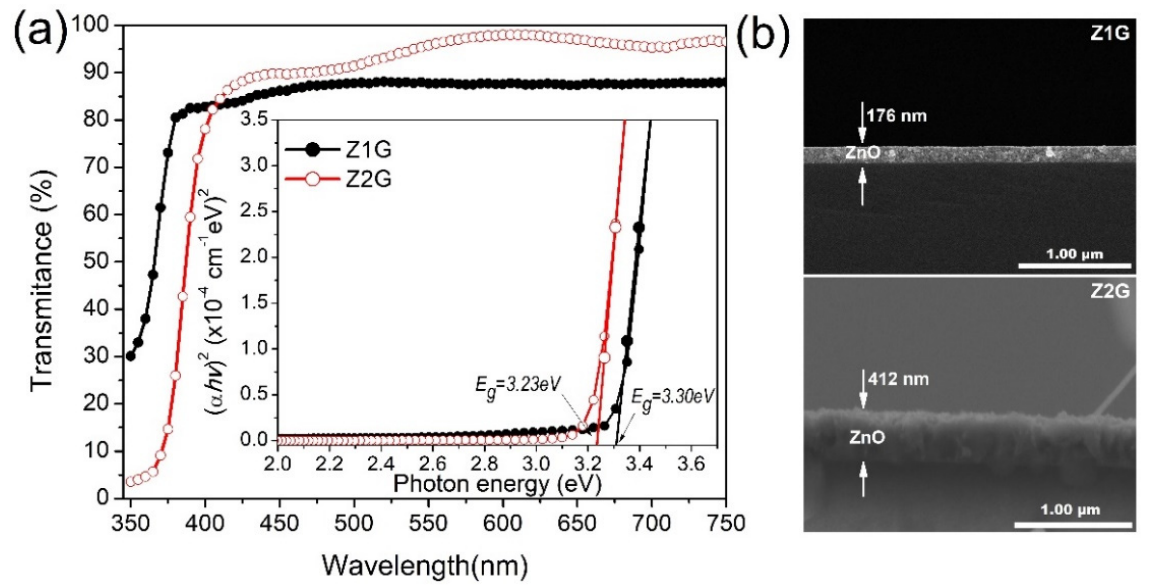
Figure 1. ( a ) Optical transmittance and band gap properties; and ( b ) cross-sectional SEM images of ZnO films deposited on corning glass by sol–gel spin coating (Z1G) and USP (Z2P) methods.